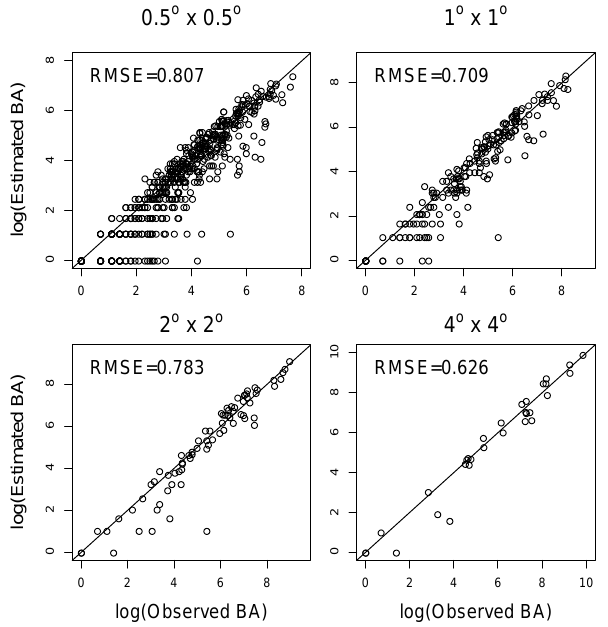
Fig. 5. Estimates of burnt area in Brazilian Amazonian forested ar- eas, in number of pixels (500m × 500m) for a range of resolutions, on a logarithmic scale. The solid line in each plot is the 1 : 1 line, and the root-mean-square errors are given for each resolution.